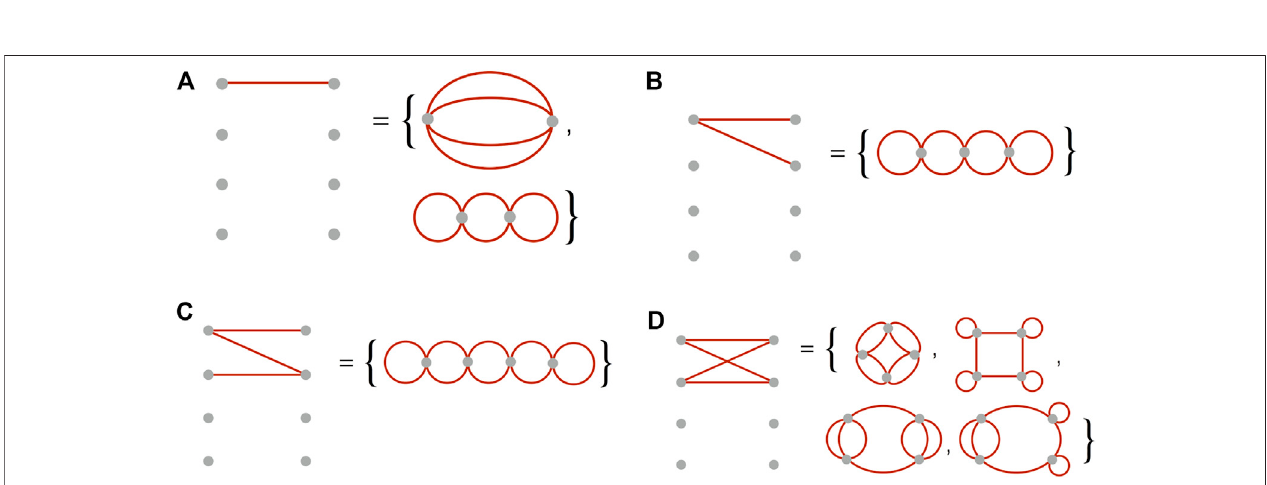
FIGURE4| The4-valentnodewithspinlabelsequalto j (cid:2) 1 / 2correspondstosuperpositionoftwographseachwiththedifferentvalueofintertwiner.Inthisarticle, the two dimensional intertwiner space is associated with the qubit Hilbert space.